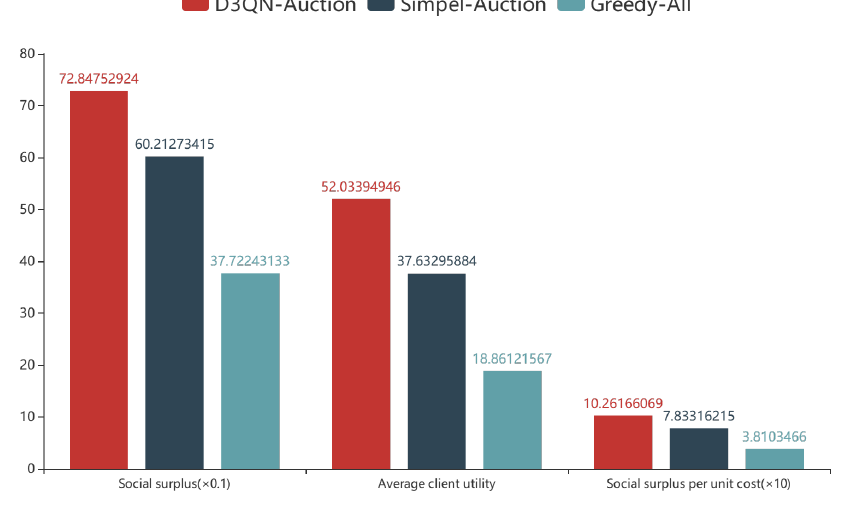
Figure 8. The comparison of economic benefits of the three